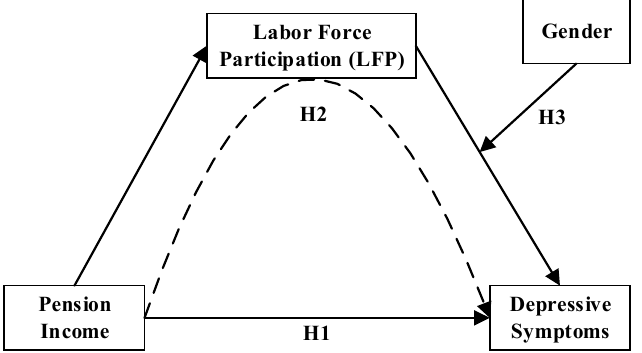
Figure 1. Conceptual diagram of the moderated mediation analysis. Note: H1—Hypothesis 1; H2—Hypothesis 2; H3—Hypothesis 3.